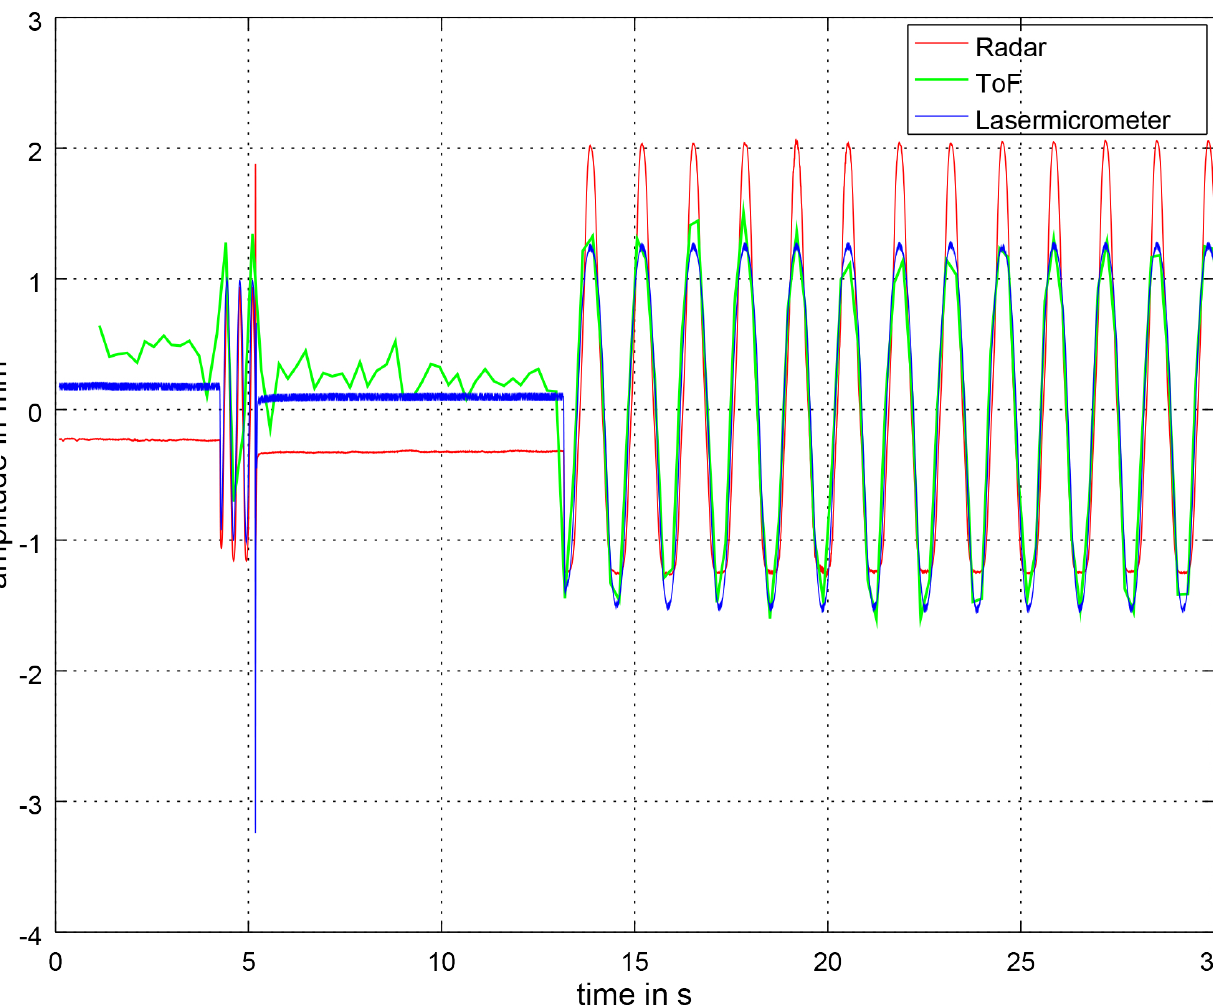
Figure 15. Unfiltered section of the respiratory signal at 45BPM deep measured by the ToF camera, the radar sensor and the laser micrometer. In the context of the ToF camera, unfiltered means that the Savitzky–Golay filter has not been applied yet. At the beginning, the synchronization signal can be seen. At the beginning of the ToF signal, the noise is clearly visible. Later on, the stroke of the simulator thorax is higher compared with the noise. The amplitude is very similar to the laser micrometer. The amplitude of the radar sensor is slightly shifted and uneven. This might be due to the effects of the applied Ellipse